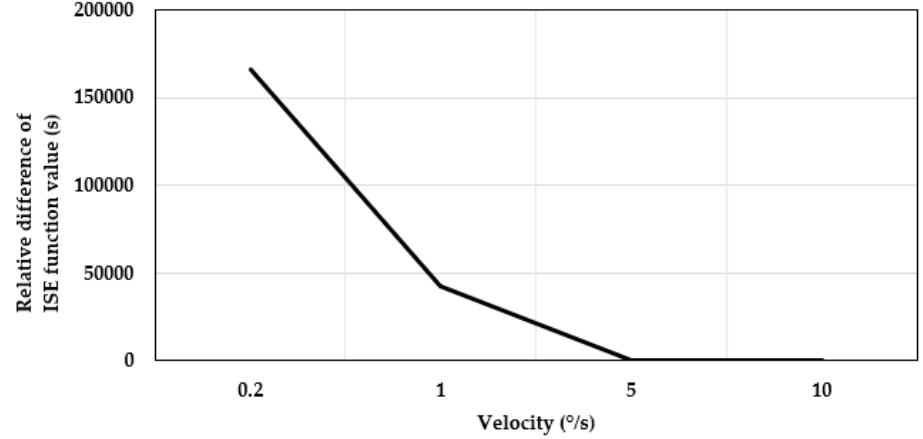
Figure 17. Relative difference between ISE of optimal parameters of driving methods.